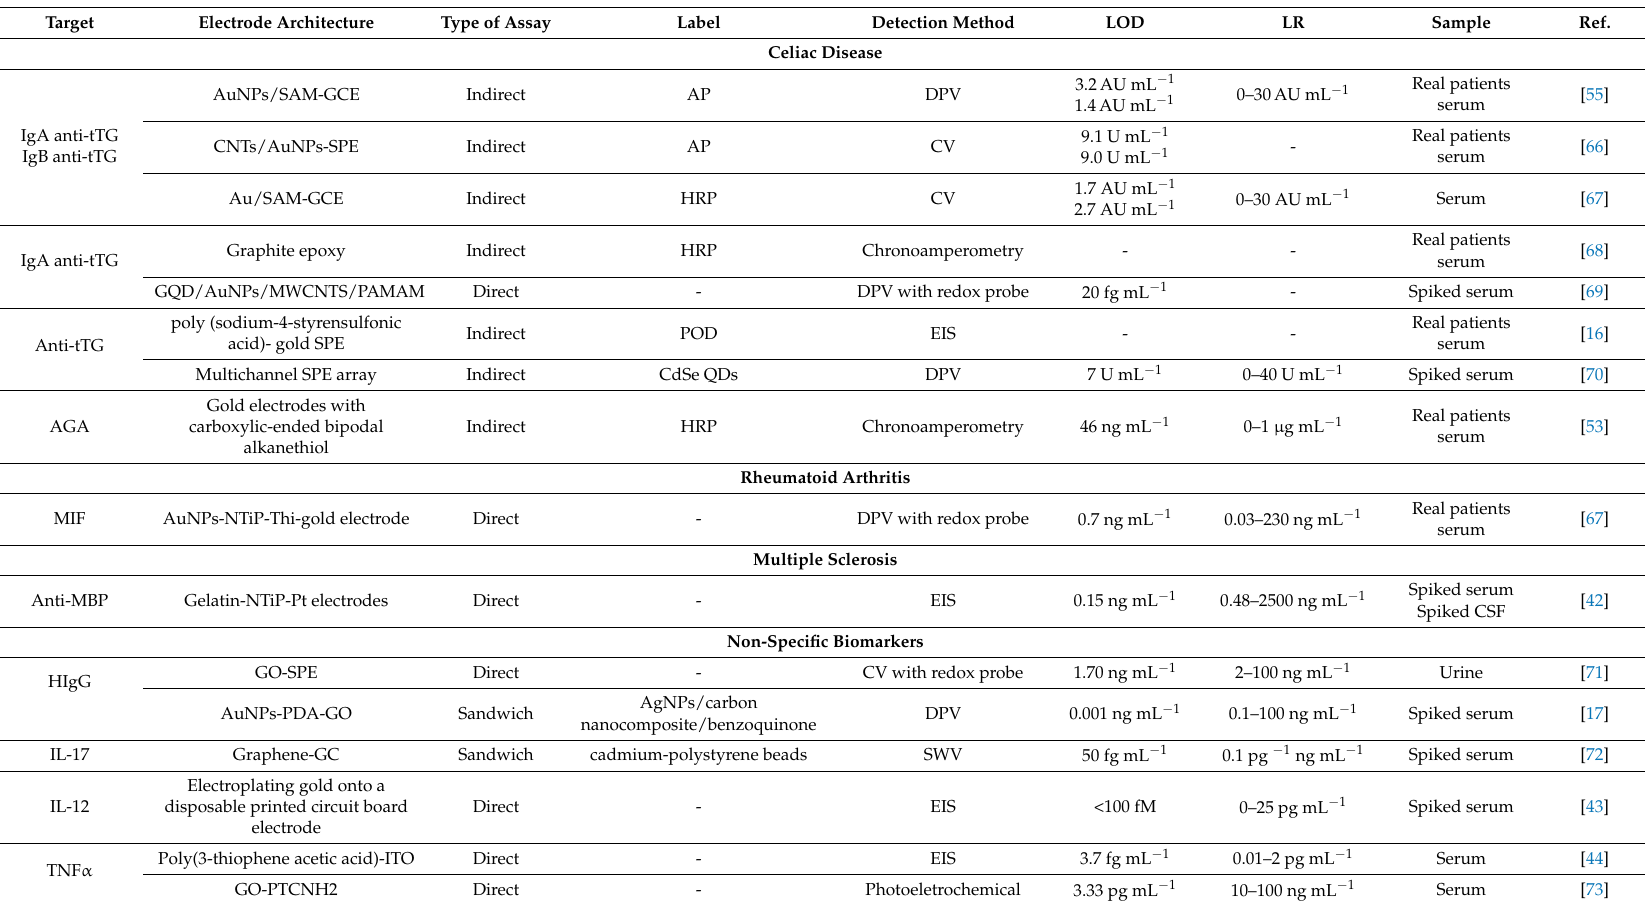
Table 1. Immunosensors based on antibodies for diagnosis and monitoring of autoimmune